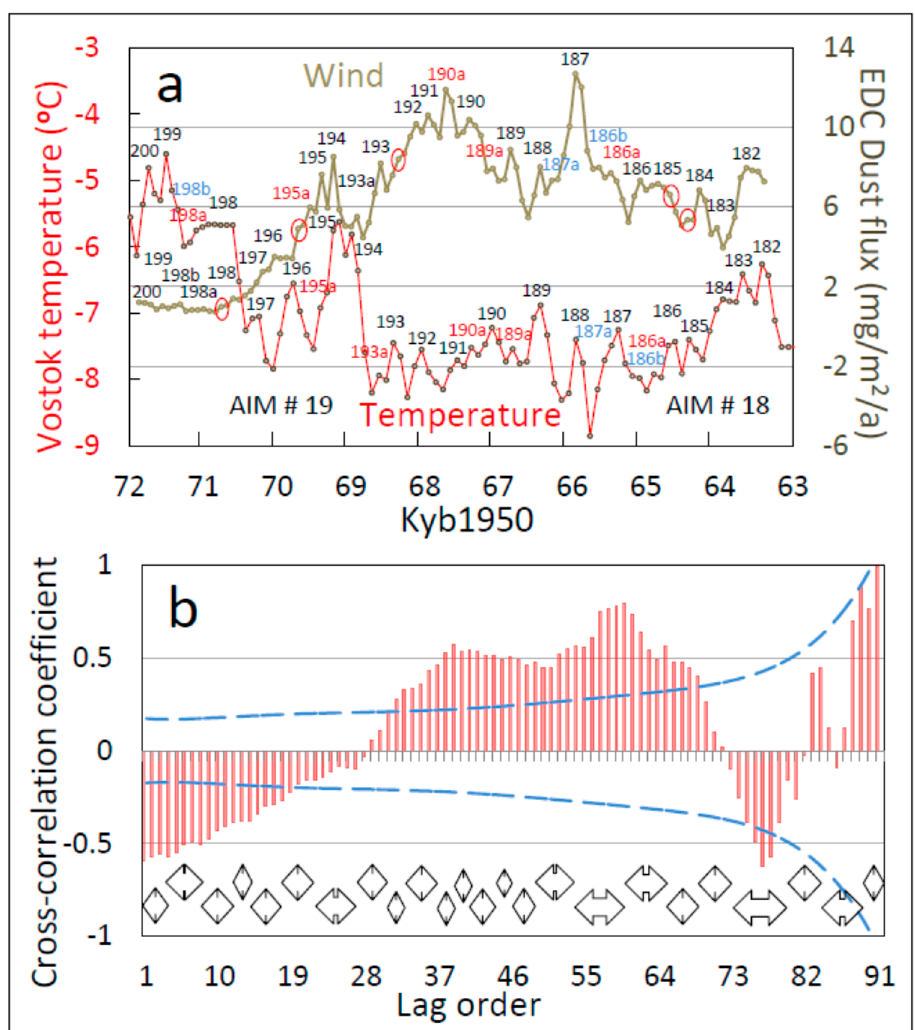
Figure 12. One-to-one coupling between proxies of wind at EPICA Dome C (EDC) and temperature at nearby Vostok during the last mid-glacial, 72-63 thousand years before 1950 (Kyb1950). ( a ) Time series showing 1:1 matching between wind peaks (brown curve) and temperature peaks (red curve) during the time of Antarctic Isotope Maxima (AIMs) 19 and 18. EDC temperature cycles are numbered following the original Vostok labeling nomenclature [12]. Additional possible AIM cycles (18a-18d, Figure 2) are not labeled in this graph. ( b ) Cross-correlogram between dust flux at EDC and temperature proxy at nearby Vostok for the time period 71.1-63.5 Kyb1950. The dashed blue lines in part (b) represent 95% confidence limits (positive and negative) for the value of the correlation coefficient associated with different lag orders (sample sizes).